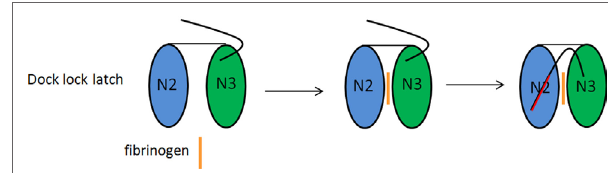
FiGURe 4 | Fibrinogen binding by serine-rich repeat proteins (Srr) 1 and Srr2 by dock, lock, and latch (DLL) mechanism. The DLL mechanism is based on the observation that Srr1 and Srr2 proteins contain two subdomains, N2 and N3. The N2 and N3 subdomains concur to create a wide trench in which resides the ligand binding site. According the DLL mechanism the ligand (FBG) binding takes place in multiple steps: the ligand region first docks into the trench, followed by conformational change and redirection of the unstructured carboxy-terminal extension of the N3 subdomain, so that amino acid residues in this extension crossover the binding trench and lock the bound ligand in place. In the final latching event, the complex is further stabilized by the insertion of the N3 C-terminus through a β -strand complementation in a trench on the surface of the N2